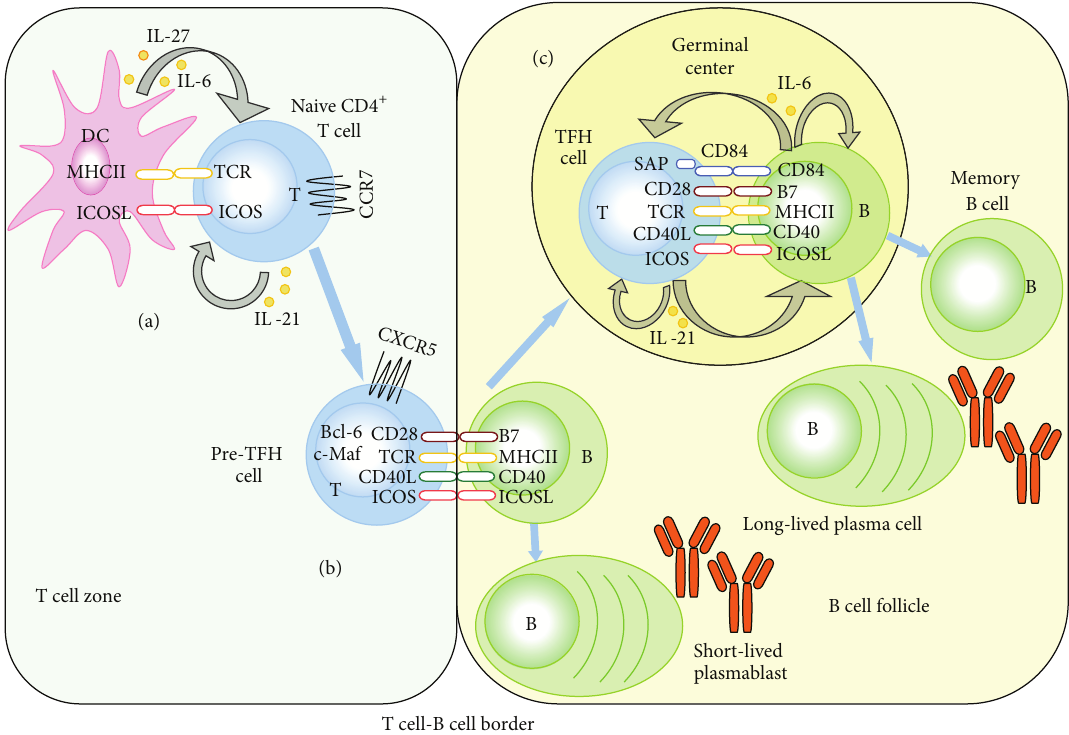
Figure 2: Multiple signals and steps for the generation of TFH cells. (a) Naive CD4 + T cells are activated when they encounter antigen presented cells-dendritic cells within T cell zone, and then these T cells move towards B cell follicles. (b) At the T cell-B cell border, activated T cells become pre-TFH cells, first interacting with cognate activated B cells, promoting either the differentiation of B cells into short-lived extrafollicular plasmablasts or the migration of B cells into follicles. (c) In germinal center, pre-TFH cells become GC TFH cells and provide help for B cell differentiation into plasma cells and memory B cells as well as antibody production. Cross-talk between TFH cells and cognate B cellsinvolvesaseriesofcostimulatorymoleculesandcytokines,whichareimportantforthefunctionofTFHcells.Reciprocalsignalsprovided by B cells are indispensable to sustain TFH cells. Bcl-6, B cell lymphoma 6; CCR7, CC-chemokine receptor 7; CD40L, CD40 ligand;